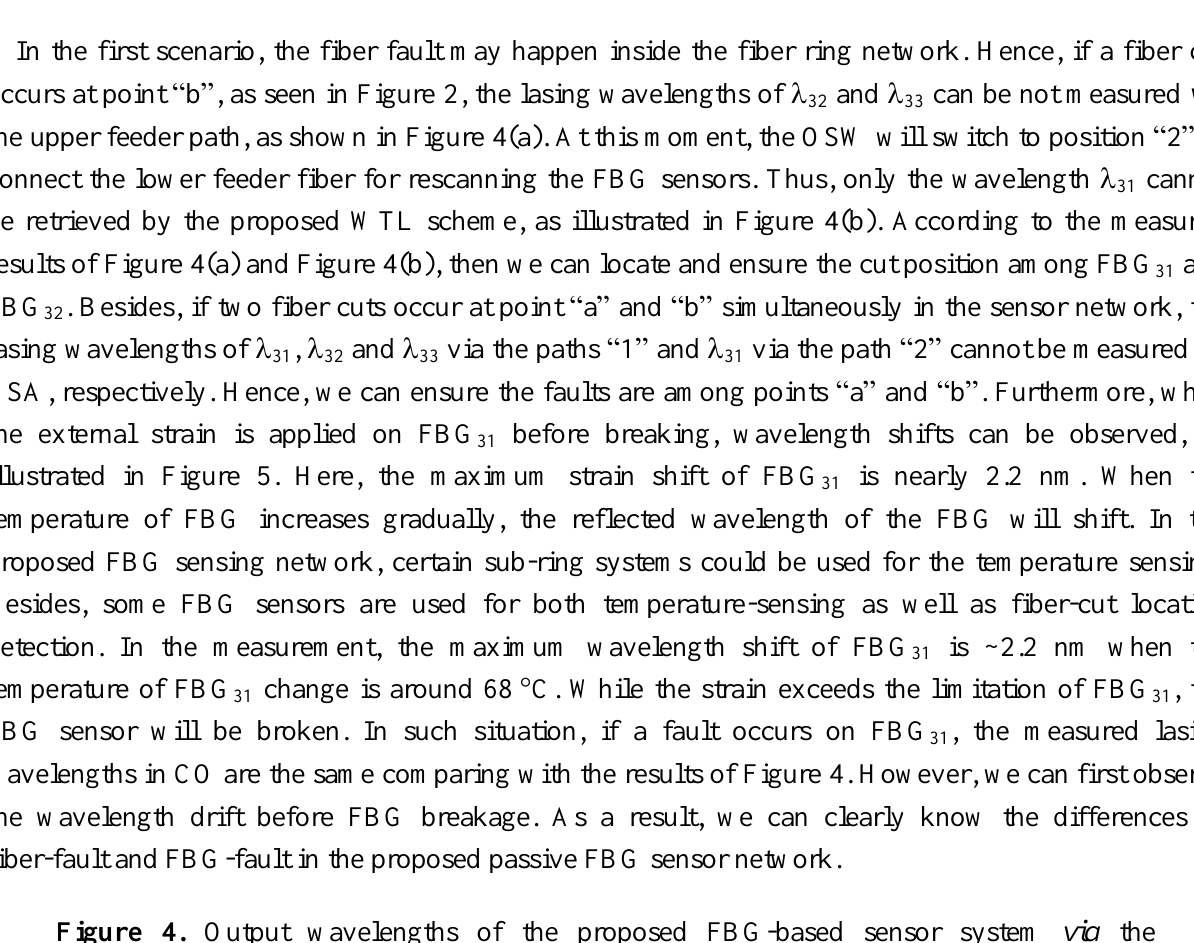
Figure 4. Output wavelengths of the proposed FBG-based sensor system via the (a) working and (b) protecting fiber links, when a cut occurs at “b” point in Figure